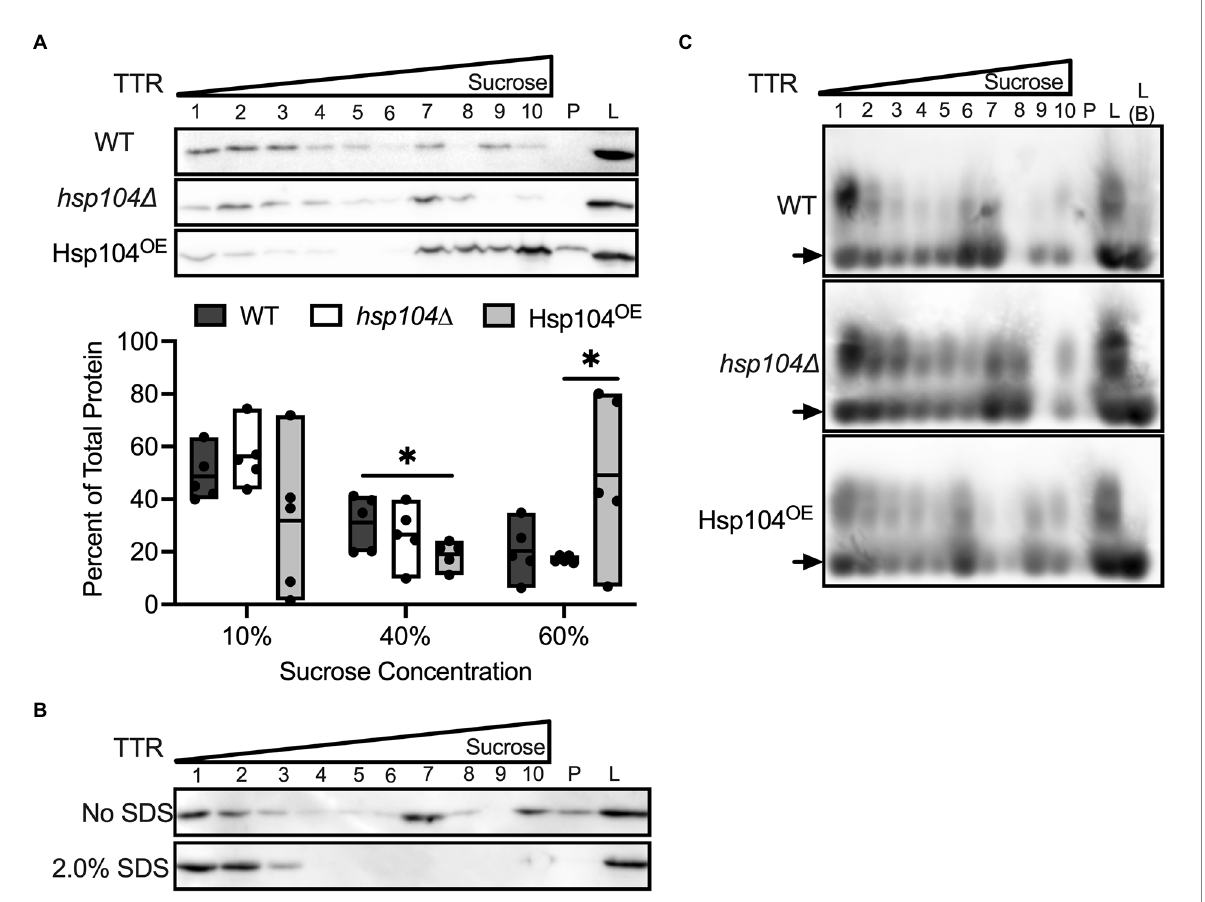
FIGURE 3 TTR sediments with higher molecular weight complexes in Hsp104 OE log cultures. (A) Lysates from the indicated strains were loaded onto a discontinuous sucrose gradient (10, 40, 60% sucrose, w/w ). 10 fractions were collected, with fractions 1–4 equivalent to the supernatant and 10% sucrose, fractions 5–7 equivalent to 40% sucrose, and fractions 8–10 equivalent to the 60% sucrose layers. P indicates pellet and L indicates separately loaded whole cell lysates. (Top) Representative blots of TTR sedimentation in log cultures are shown. (Bottom) Quantification of sedimented TTR signal in fractions 1–4 (10%), fractions 5–7 (40%), or fractions 8-P (60%) compared to total protein in all fractions. All quantification represents 4–6 independent cultures per strain. Data is shown as means and ranges. * p ≤ 0.05 by unpaired two-tailed t -test. (B) The lysates of WT strain in log growth were either treated in the presence or absence of 2.0% SDS prior to centrifugation on discontinuous sucrose gradients. Gradients were spun at 25 ° C to prevent SDS precipitation. (C) Untreated lysates were subjected to sucrose gradient sedimentation, and lysates were resolved by SDD-AGE and visualized with anti-TTR. Note that L (B) indicates crude lysate that were boiled prior to loading. Arrows denote TTR monomers. Representative images are